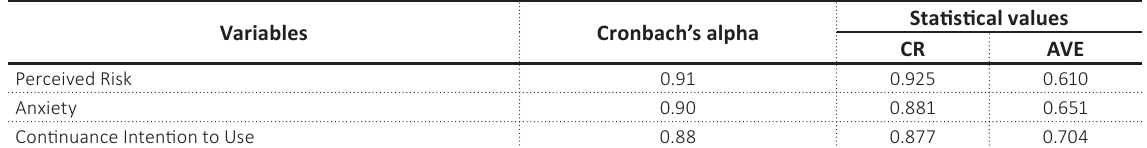
Table 2. Measurement model